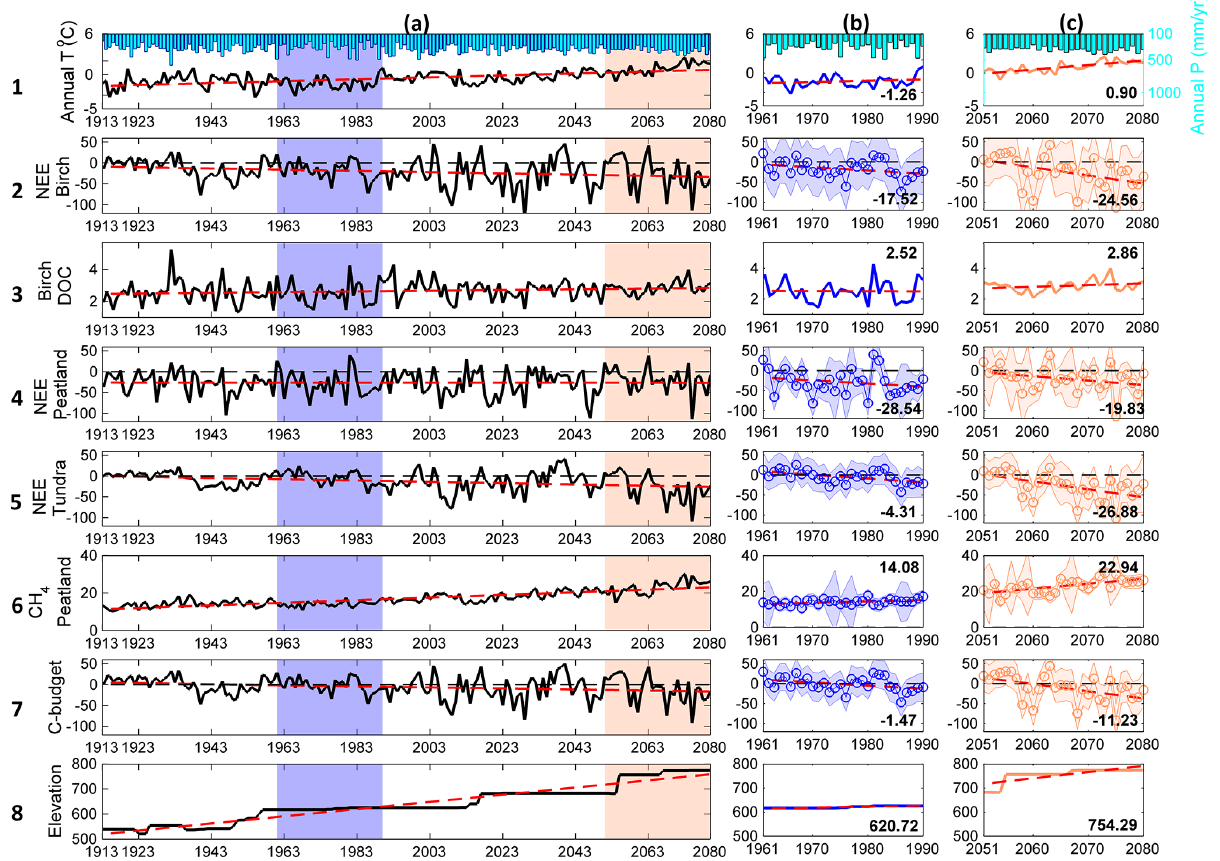
Figure 6. Time series (a) of annual mean temperature, precipitation sum, NEE (gCm 2 yr − 1 ), averaged DOC export (gCm 2 yr − 1 ) from the birch forest, birch treeline elevation (m) and catchment C budget (gCm 2 yr − 1 ) values between 1913 and 2080. The NEE data for the birch forest and the peatland have had the corresponding DOC and DIC values subtracted. Here the averaged C fluxes from the Stordalen peatland (the northeast side of the catchment) are used to represent for the averaged C fluxes for the whole-catchment peatlands since only the Stordalen peatland DOC and DIC observations are currently available. The aerial photo-based classification of the Eriophorum and Palsa/ Sphagnum peatland fractions within the Stordalen peatland is used to scale up the C fluxes. The trend of each data set is shown with a red dashed line. The second and third columns (b, c) of the figure focus on the periods 1961–1990 and 2051–2080 (these two periods are also indicated in the first column with shaded area). The numbers in bold in columns (b) and (c) show the annual average of each quantity for the respective time period. The fractions of peatland, birch forest, tundra and lakes/rivers are 5.7, 57.69, 29.76 and 5%, respectively. Approximately 1.79% of the catchment area is estimated as being dominated by C3G and HSE, which are not included in the above classification. The last row shows the birch treeline elevation changes over the